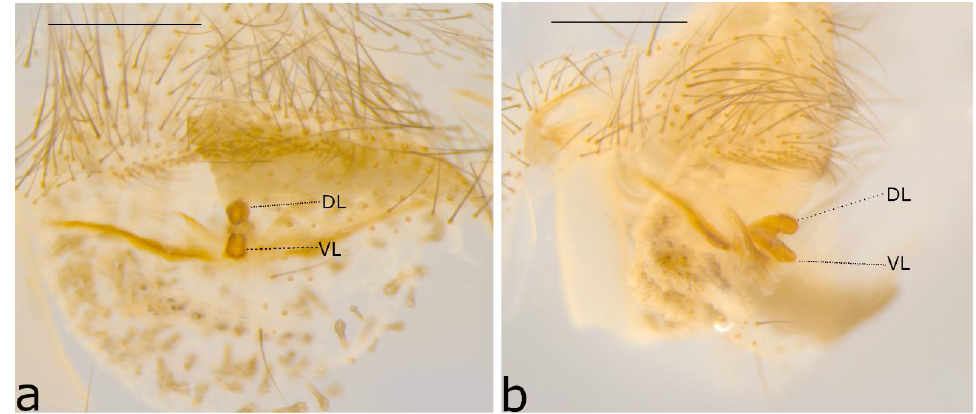
Figure 49. Ariadna propria sp. nov. ♀ paratype (SAMA NN30536a) from Melrose (SA): anterior re- ceptaculum ( a ) ventral view; ( b ) same, lateral view. Scale bar = 0.5 mm. DL = dorsal lobe, VL = ventral